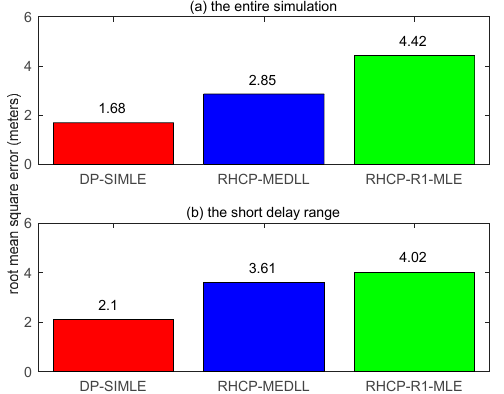
Figure 11. The RMSE of the three multipath mitigation algorithms. ( a ) RMSE in the entire simulation; and ( b ) RMSE in the short delay range.